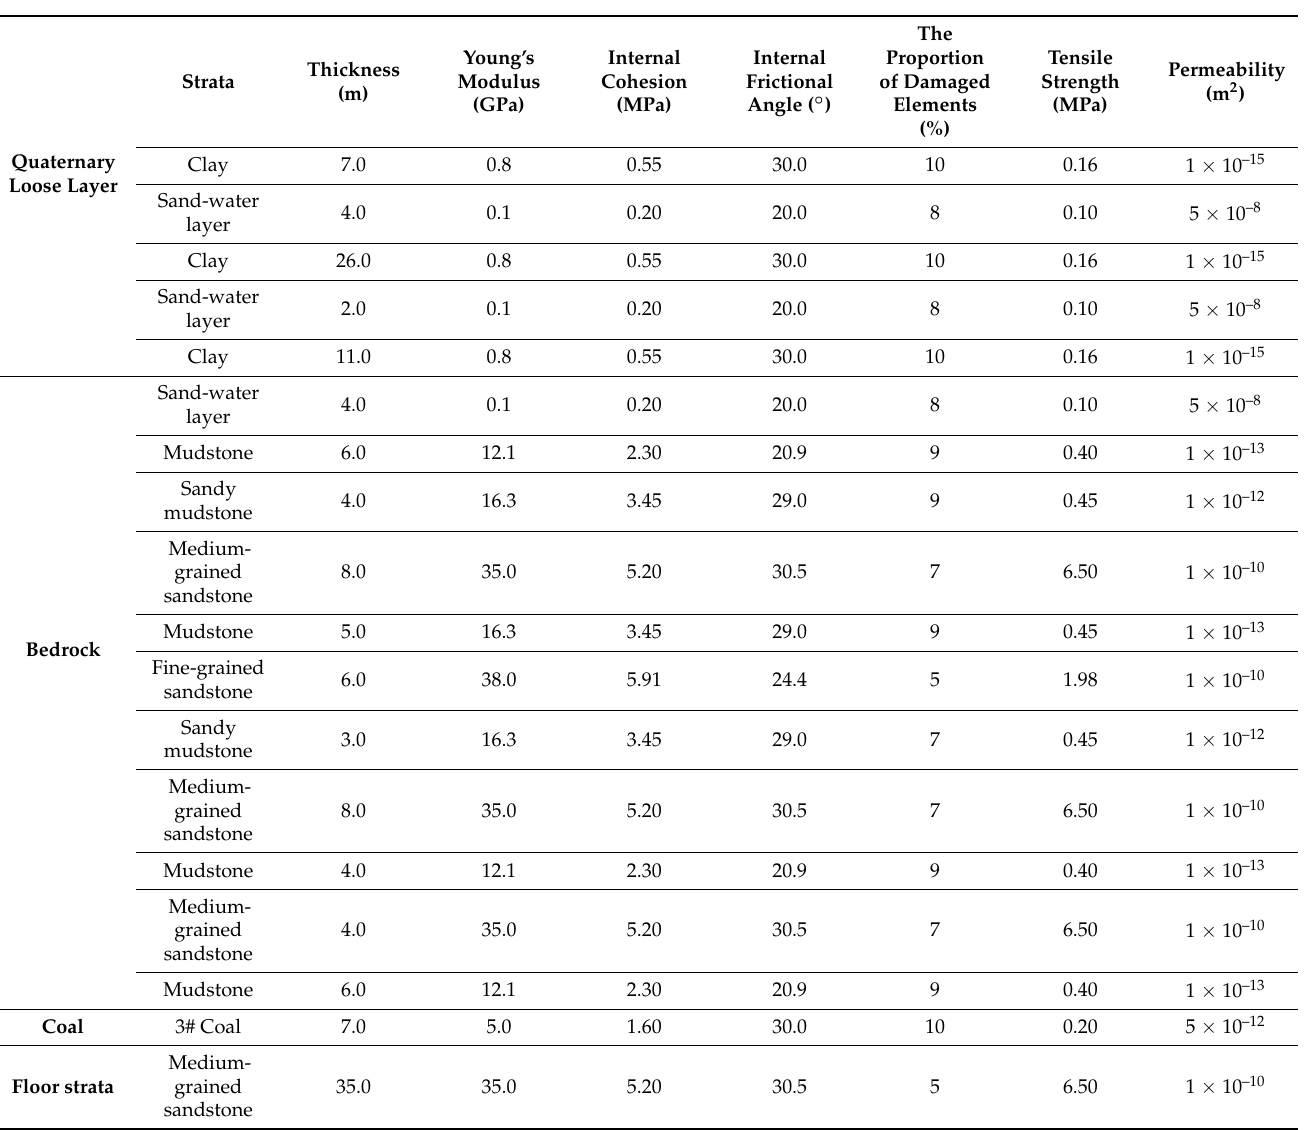
Figure 2. Numerical calculation model. Table 1. Numerical model